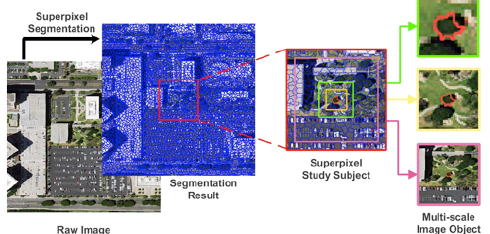
Figure 3. Production of superpixel dataset in multiple scales